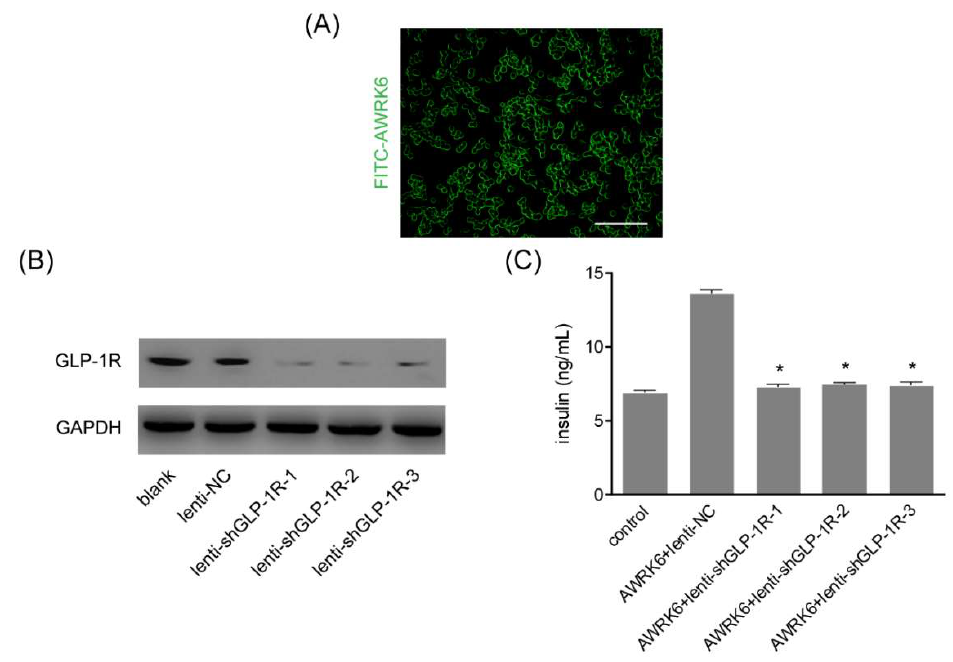
Figure 5. AWRK6 was a GLP-1 receptor (GLP-1R) agonist. ( A ) AWRK6 interacted with Min6 cells outer membrane, assayed by incubation with FITC-conjugated AWRK6. Scale bar indicates 100 μm. ( B ) The GLP-1R silencing using lentivirus was verified by western blotting. ( C ) The insulin secretion in GLP-1R-silenced Min6 cells treated with AWRK6. The error bar indicates standard deviation. * p < 0.05 compared with the AWRK6 + lenti-NC groups.